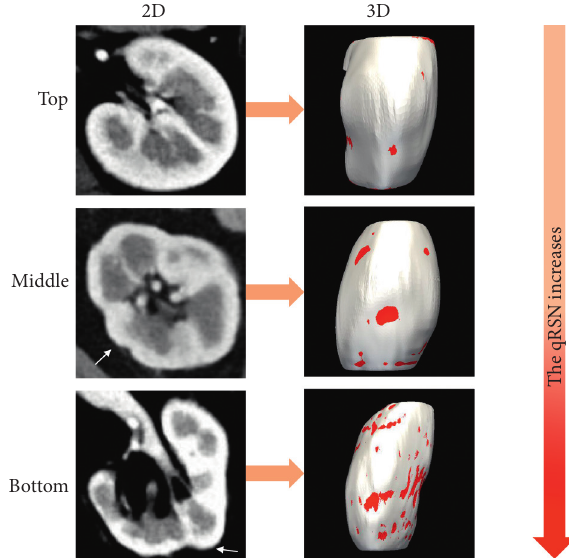
Figure 3: Axial and 3D diagrams of qRSN on the renal surface of patients with arterial hypertension (white arrows and red areas). Top (the left kidney of a 44-year-old man in the control group), his qRSN is 1.428. Middle (the left kidney of a 56-year-old woman in the ERI group), renal surface nodularity (RSN) was detected on the axial CTimage and 3D diagram. Her qRSN is 1.610. Bottom (left kidney of a 42-year-old man in ERI group), RSN was detected on the axial CT image and 3D diagram. His qRSN is 2.155. Table 1: Clinical characteristics and quantitative classification of renal surface nodularity in patients with arterial